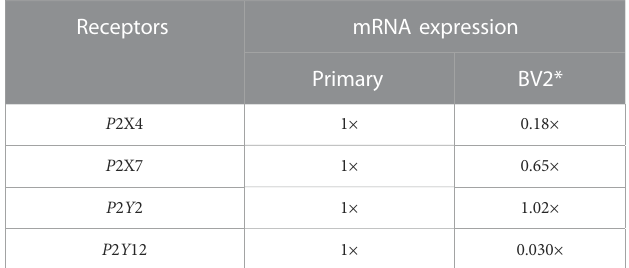
TABLE 1 Relative expression of P2 receptors in acutely isolated, primary cultured microglia, and BV2 cells in relative scale. Reported receptor mRNA expression is normalized to the expression level (mRNA count) found in primary cultured microglia and are incorporated in our model as scaling factors for receptor concentration( ρ P2X4 , ρ P2X7 , ρ P2Y2 ,and ρ P2Y12 ).*ThemRNAexpressionwasacquired from the comparison between cultured mouse microglia and BV2 cells (He et al.,